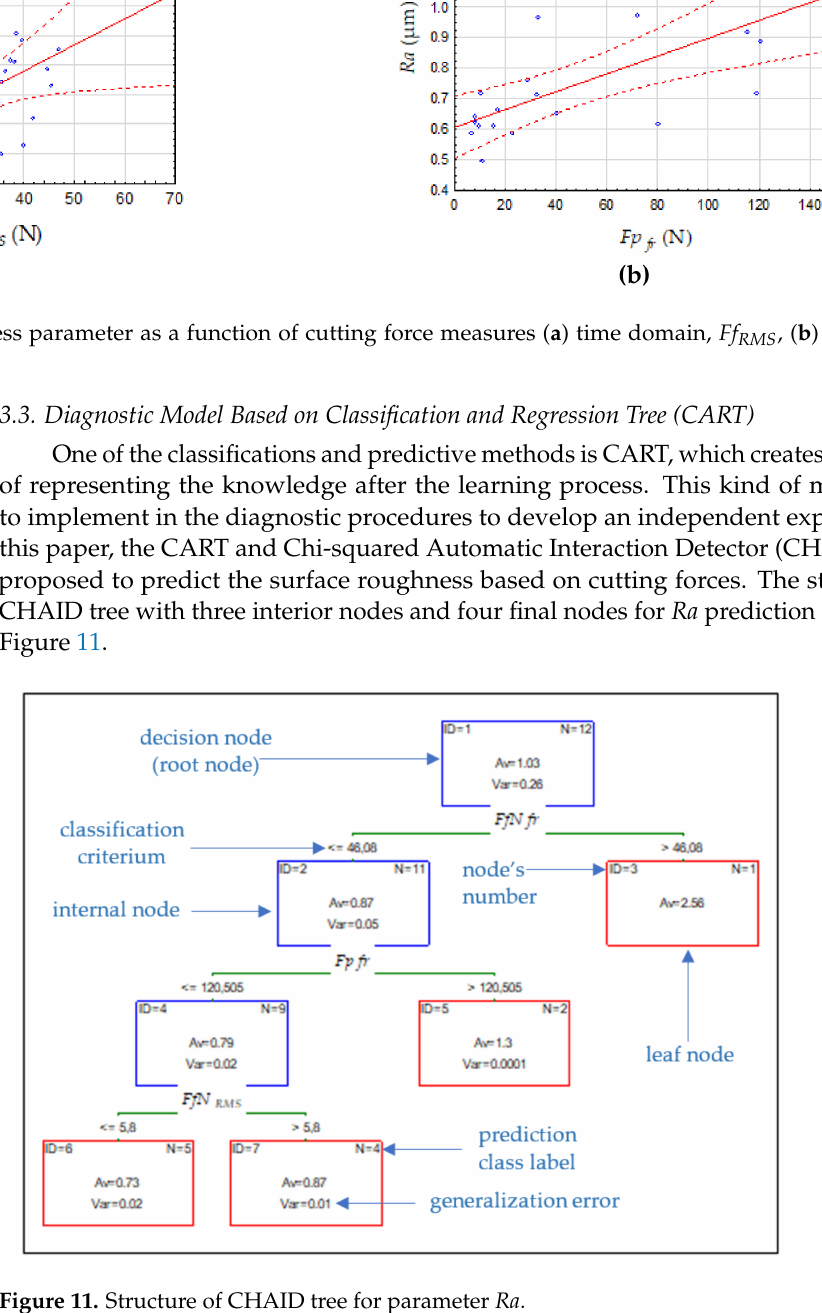
Figure 11. Structure of CHAID tree for parameter Ra